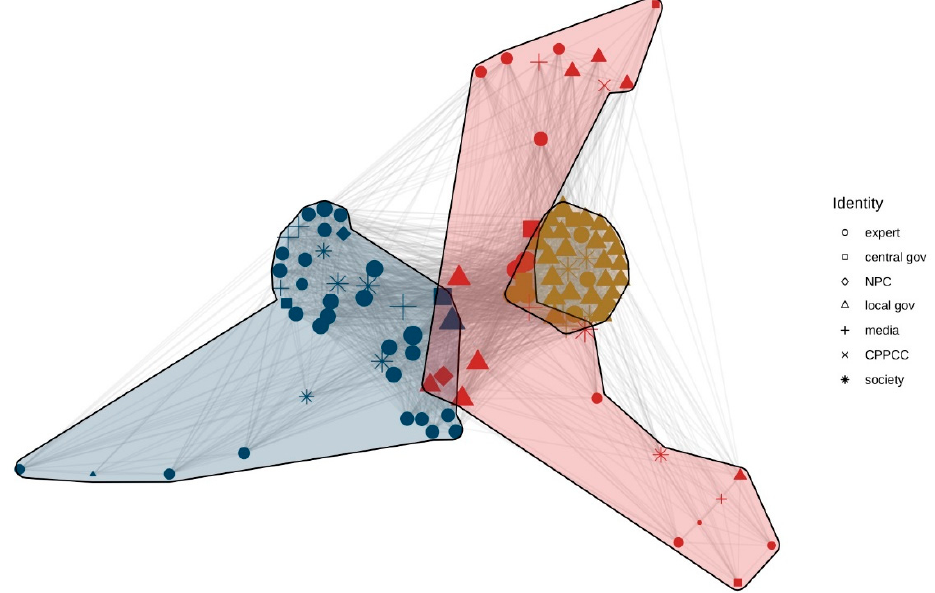
Figure 6. Discourse network visualisation (2013–2015).